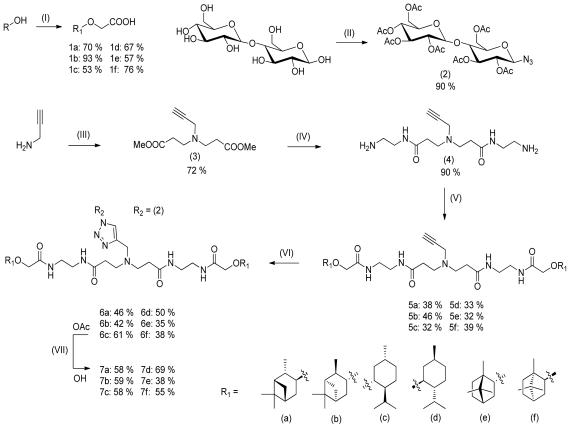
Synthesis of the chiral water soluble guest dimers 7a–f. (I) BrCH2COOH, NaH, dioxane, 24 h; (II) a. I2, Ac2O, 10 min, b. TMSN3, SnCl4, CH2Cl2, 12 h; (III) CH2CHCOOCH3, 48 h; (IV) NH2C2H4NH2, 72 h; (V) EDCI, Oxyma pur ©, NMM, DMF, 18 h; (VI) CuSO4, sodium ascorbate, DMF, H2O, 18 h; (VII) NaOMe, MeOH, Dowex HWCR 20, 12 h.